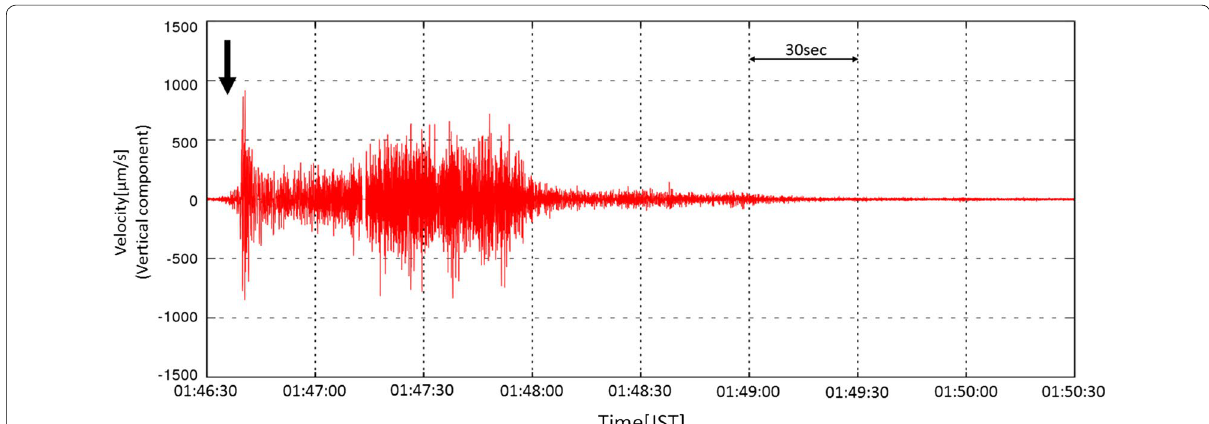
Fig. 2 The volcanic earthquake (vertical component) as measured by a seismogram from Aso volcano eruption, 8 Oct., 2016, 01:46:30–01:50:30JST. The observation point is located approximately 1.2 km west from the vent. The black arrow indicates the eruption time (around